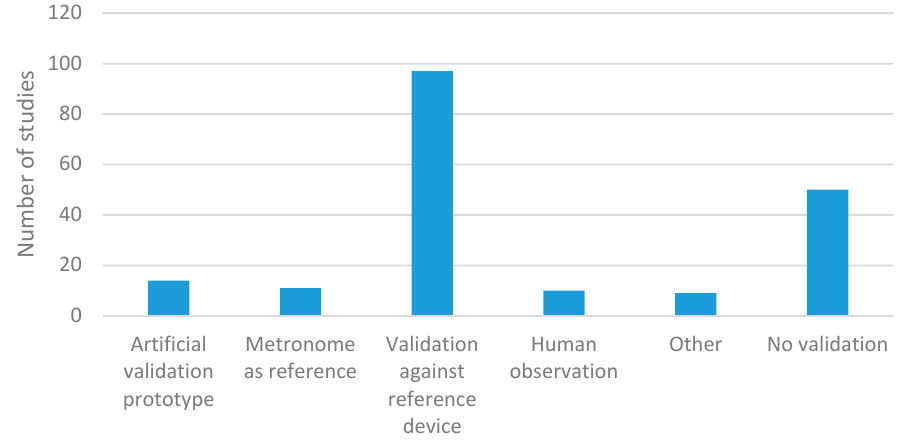
Figure 28. Number of studies that adopted the different validation approaches. Table 5. Analysis of validation experiments for the studies in the wearable and environmental categories.